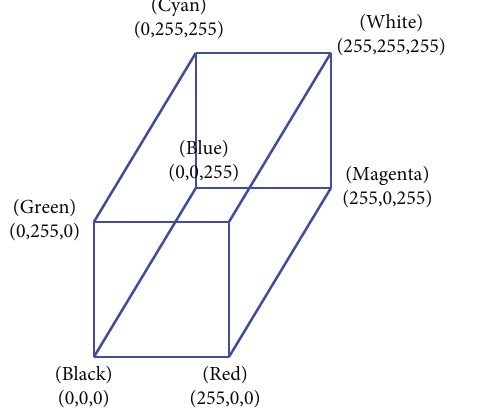
Figure 1: RGB model cube.